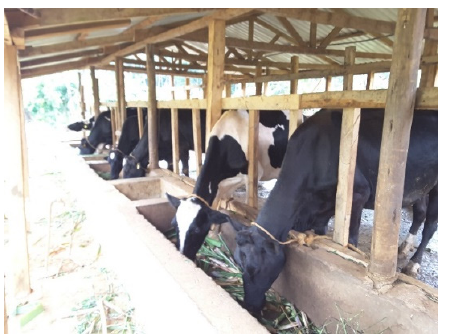
Figure 7. Improved dairy cattle genotypes in positive deviants and typical farms under stressful production environments.